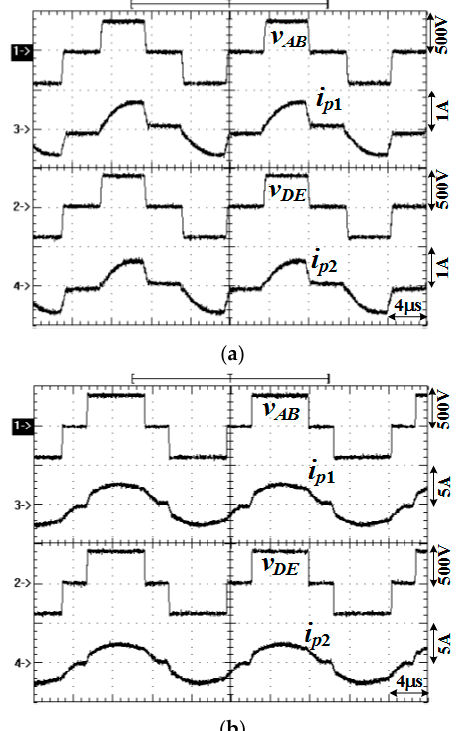
Figure 6. Measured primary-side waveforms of phase-shift PWM converter under ( a ) 20% load ( b ) 100% load.